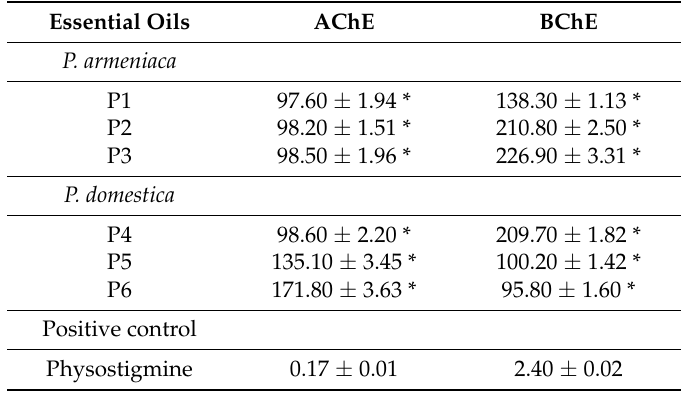
Table 3. Acetylholinesterase (AChE) and butyrylcholinesterase (BChE) inhibitory activity of P. armeniaca and P. domestica leaves essential oils (IC 50 μg/mL).